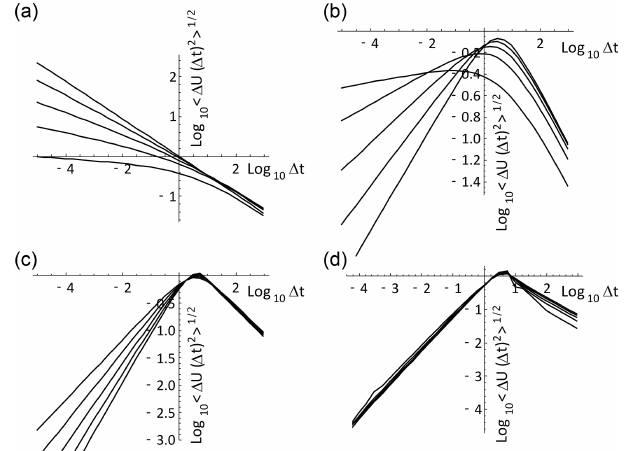
Figure 5. The rms Haar fluctuation plots for the pure ( α = 0) fRn process for 0 < h < 1 / 2 (a) , 1 / 2 < h < 1 (b) , 1 < h < 3 / 2 (c) , and 3 / 2 < h < 2 (d) . The individual curves correspond to those of Figs. 3 and 4. The small (cid:49)t slopes follow the theoretical values h − 1 / 2 up to h = 3 / 2 (slope = 1); for larger h , the small t slopes all equal 1. Also, at large t due to dominant V ≈ t terms, in all cases we obtain slopes t − 1 / 2